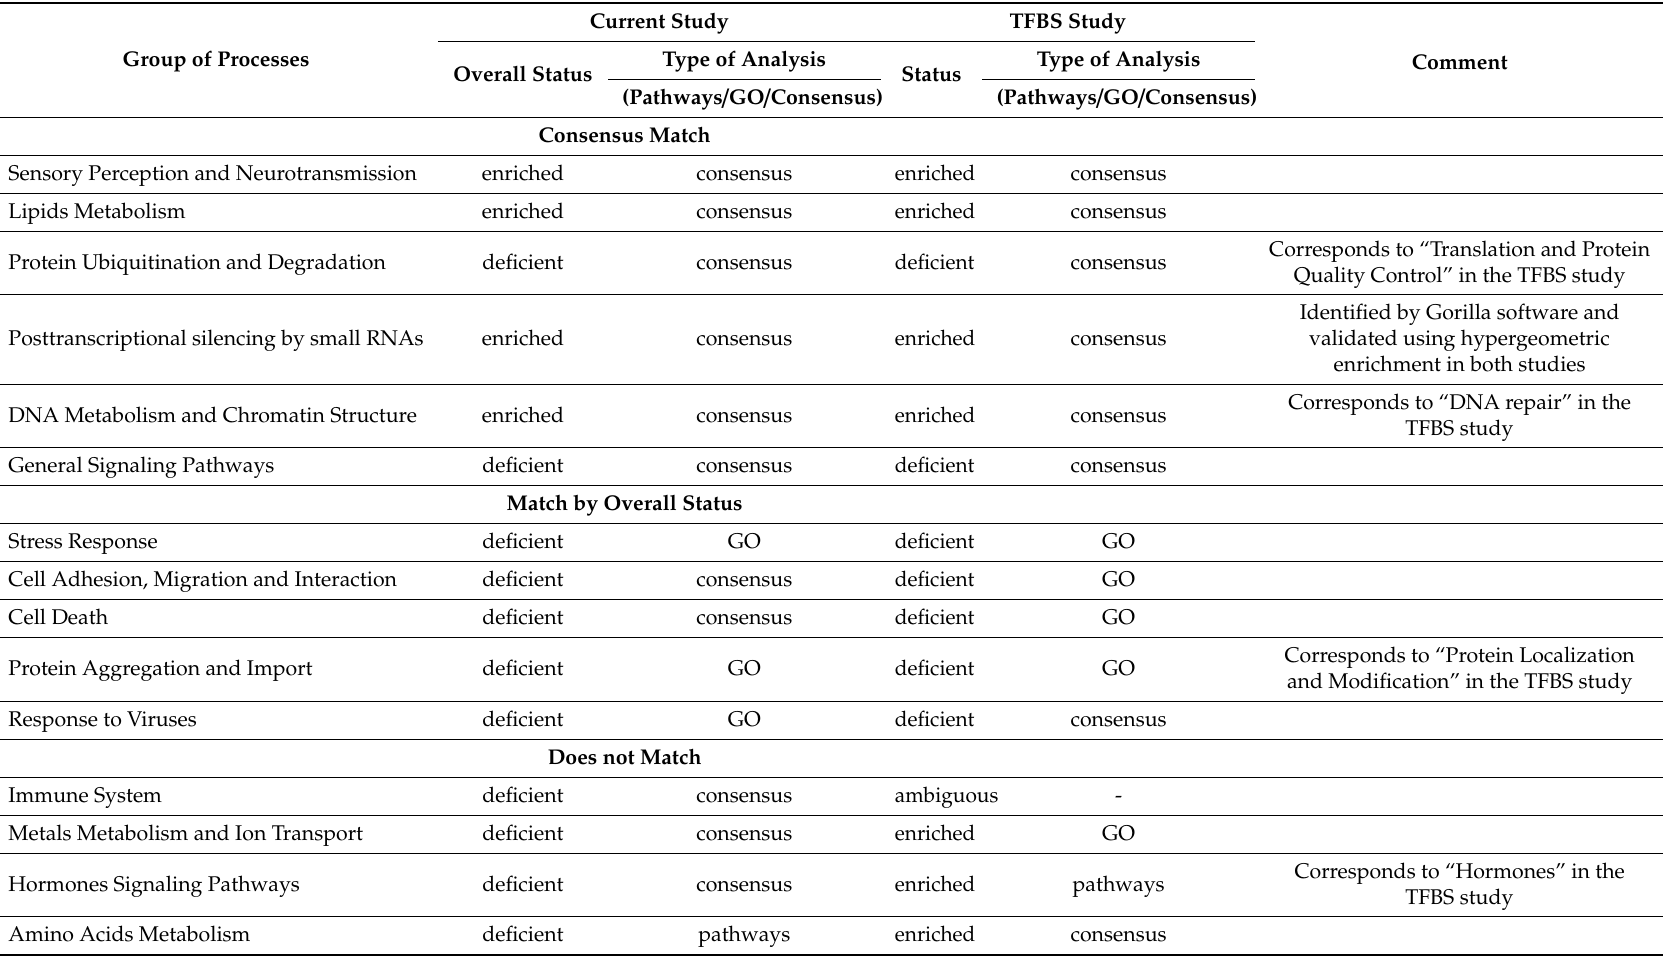
Table 3. Comparison of isolated groups of processes in current study and in TFBS study